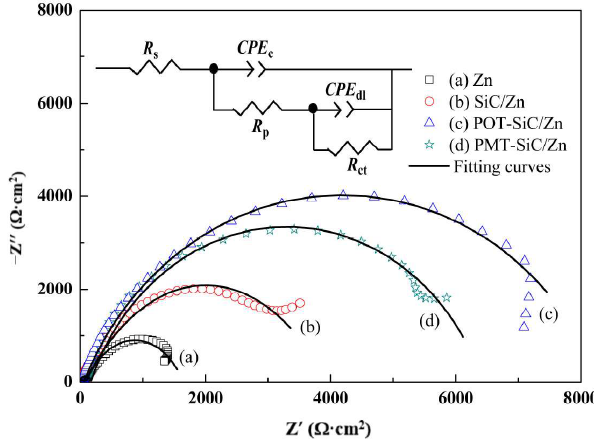
Figure 9. Nyquist plots of electrodeposited and bilayer coatings after immersion in 3.5% NaCl solution for 168